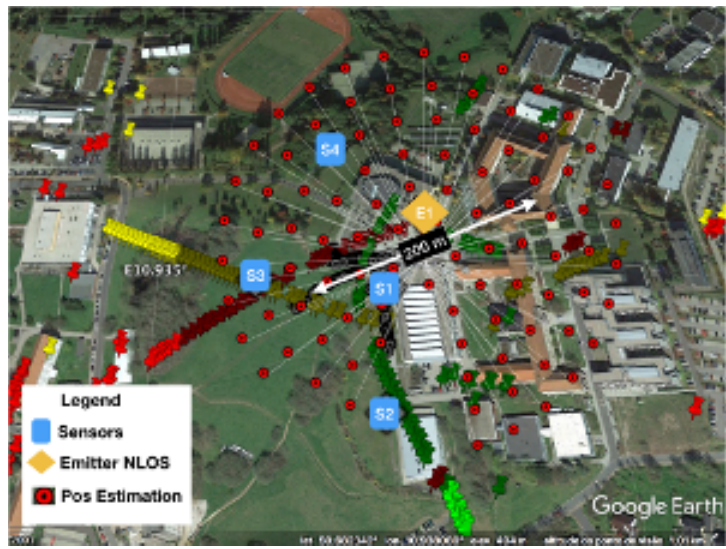
Figure 24. Position estimation error in NLOS.